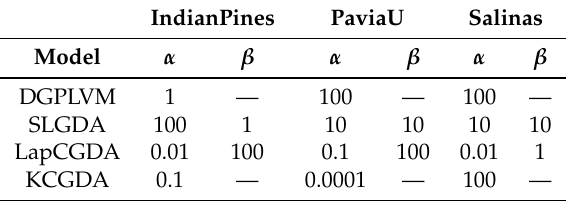
Table 2. Optimal parameters settings for DGPLVM, SLGDA, LapCGDA and KCGDA on three HSI